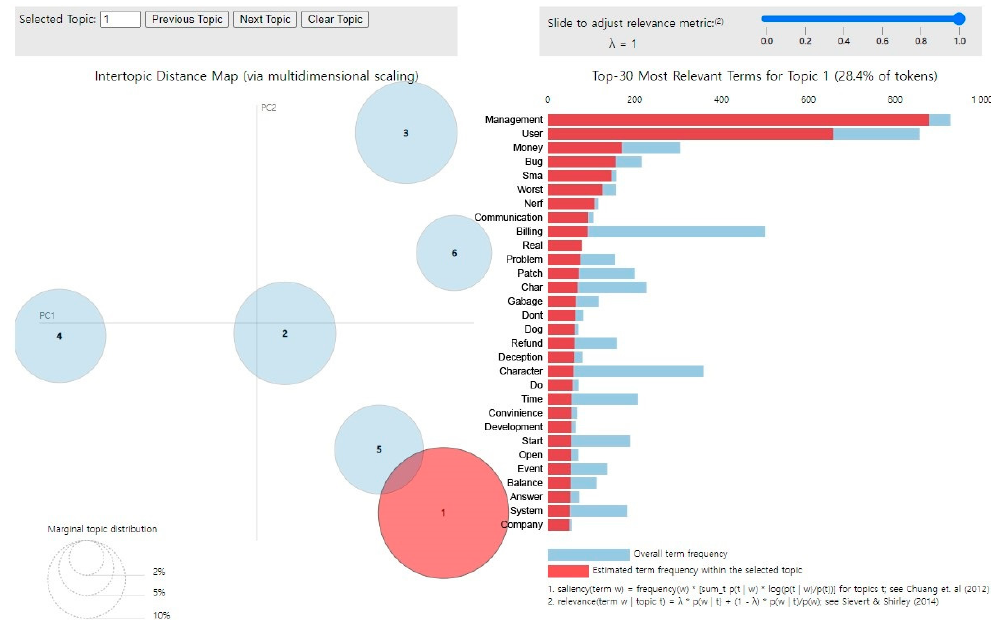
Figure 6. Results of topic analysis of Game C by pyLDAvis. Table 2. Grouped terms and inferred